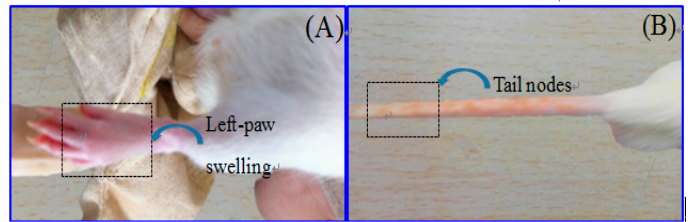
Figure 2. Effects of brucine gel on secondary arthritis in AA rats. Images show secondary adjuvant arthritis symptoms in ( A , B ), which appeared on the 13th day after injection with FAC.